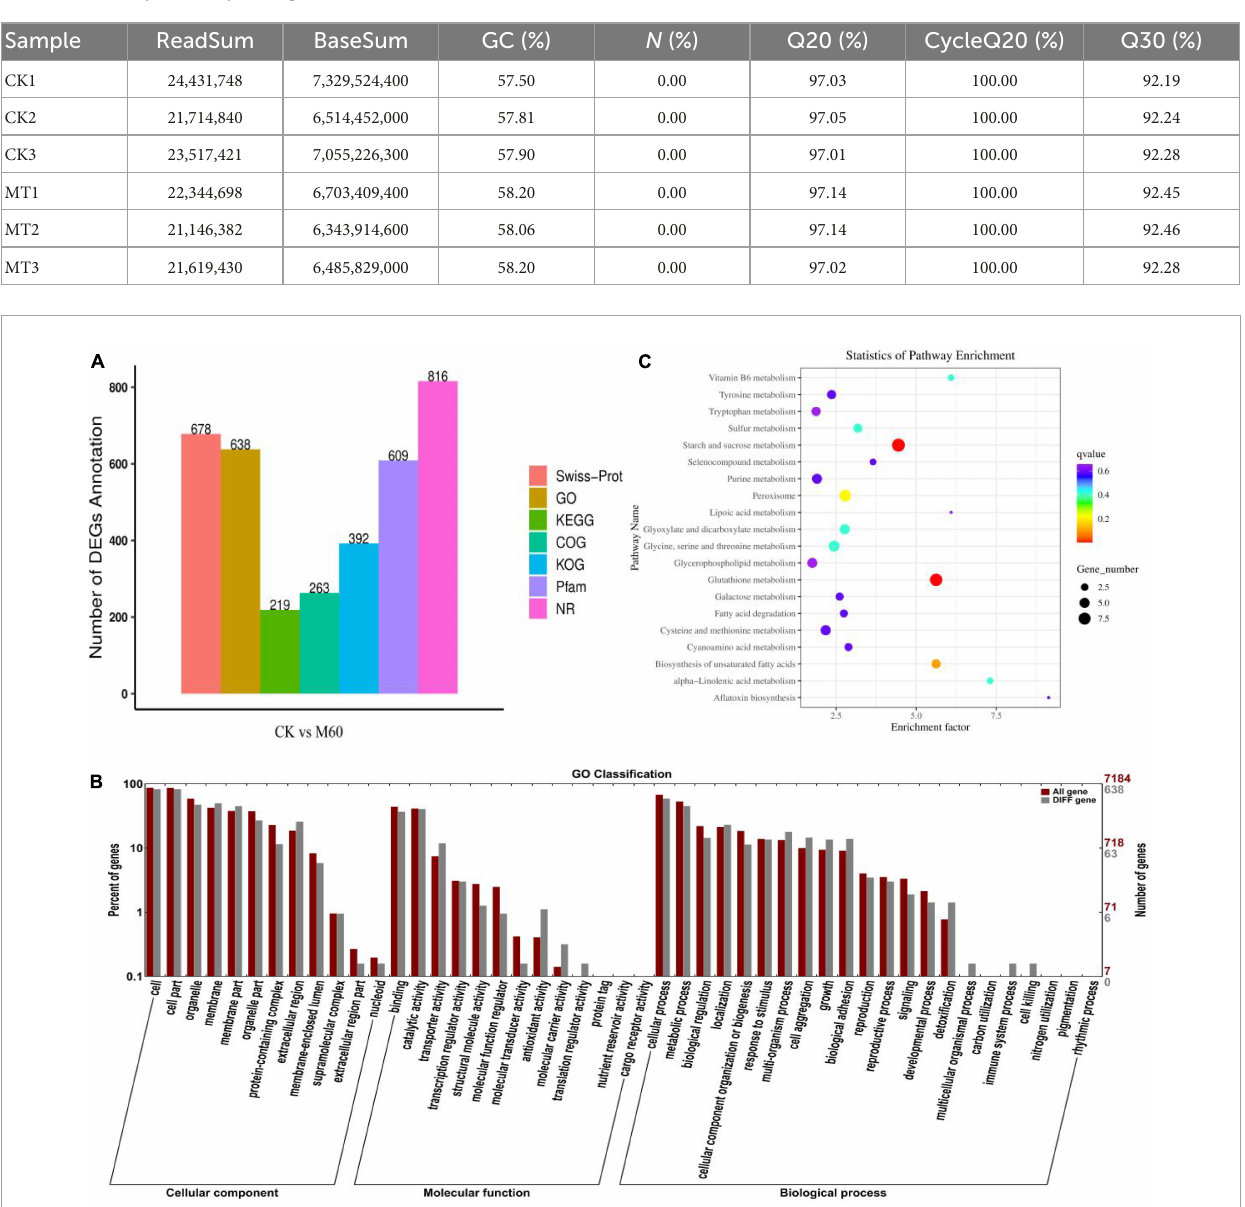
FIGURE4 Statistics and analysis of DEGs in C. militaris strains. (A) Number of genes annotated in Swiss-Prot, GO, KEGG, COG, KOG, Pfam, and NR. (B) Go enrichment analysis in CK vs. M60. The abscissa is the GO classification, the left side of the ordinate is the percentage of the number of genes, and the right side is the number of genes. This figure shows the gene enrichment of each secondary function of GO under the background of differentially expressed genes and all genes, reflecting the status of each secondary function under the two backgrounds. (C) KEGG enrichment analysis in CK vs. M60. Each row in the figure represents a KEGG path. The abscissa is the enrichment factor, indicating the ratio of the proportion of genes annotated to the pathway in the differential gene to the proportion of genes annotated to the pathway in all genes. The larger the enrichment factor, the more significant the enrichment level of differentially expressed genes in this pathway. The color of the dot represents q value, and the size of the dot represents the number of differential genes in the annotation pathway. M60, add 60 µ mol L − 1 of MT.